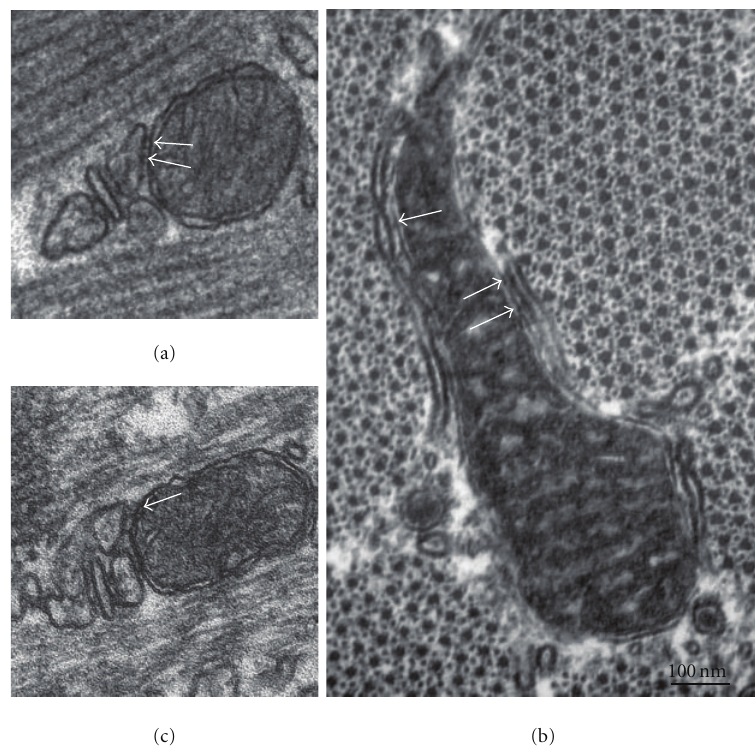
Figure 2: Higher magnifications highlighting association of mitochondria and SR (a)–(c). Tethering connections anchor mitochondria to the jSR of the triads (CRUs) in images of mouse EDL ((a) and (c), white arrows). Similar tethers (white arrows) anchor mitochondria to the longitudinal SR, not necessarily to CRUs, in the leg muscle from a finch